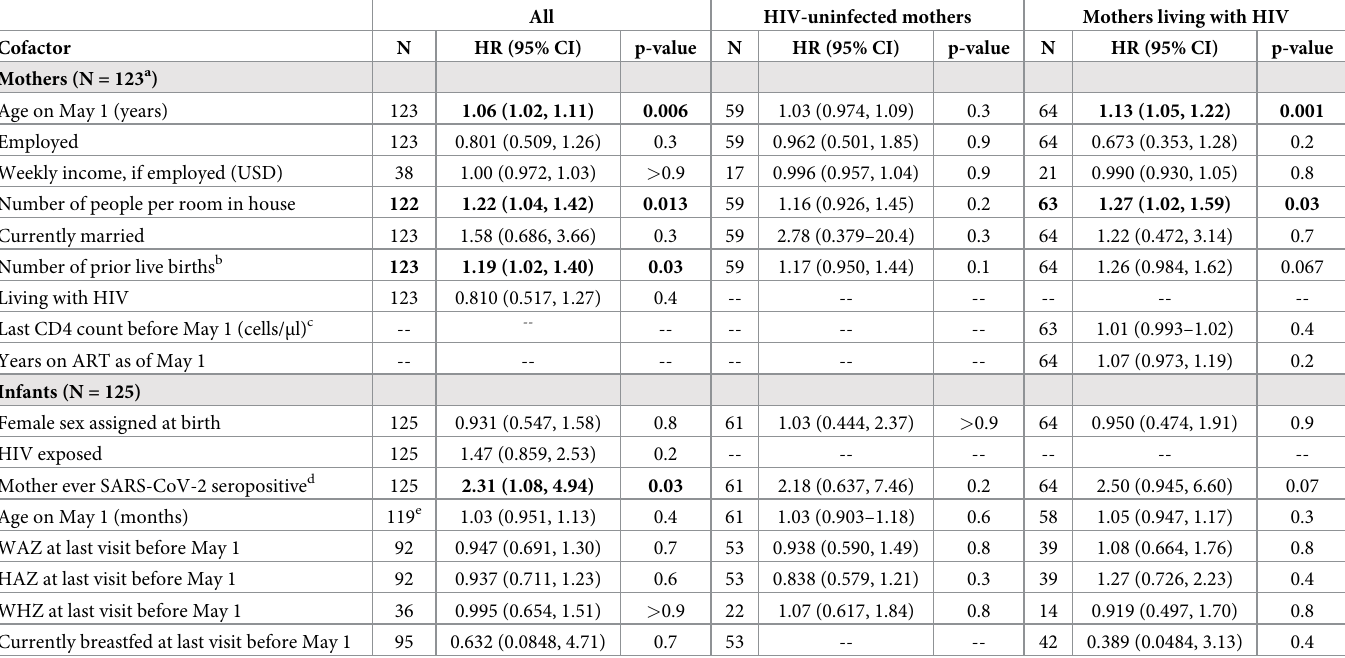
Table 3. Correlates of SARS-CoV-2 infection in mothers and